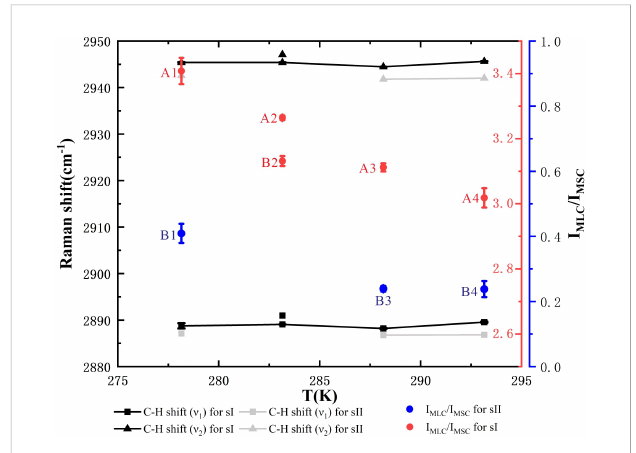
FIGURE 6 Raman spectra of the n 1 and n 2 C – H stretch of ethane for mixed hydrates and Raman peaks area intensity ratios (PARs) of CH 4 in the large cages (LC) to small cages (SC) (I MLC /I MSC ). Black points and line segments correspond to structure I (sI) hydrate samples A1, A2, A3, A4, and B2. Gray points and line segments correspond to structure II (sII) hydrate samples B1, B3, and B4, with lower wavenumbers. The red dots marked with the sample number correspond to the red coordinate axis on the right, and the blue dots marked with the sample number correspond to the blue coordinate axis on the